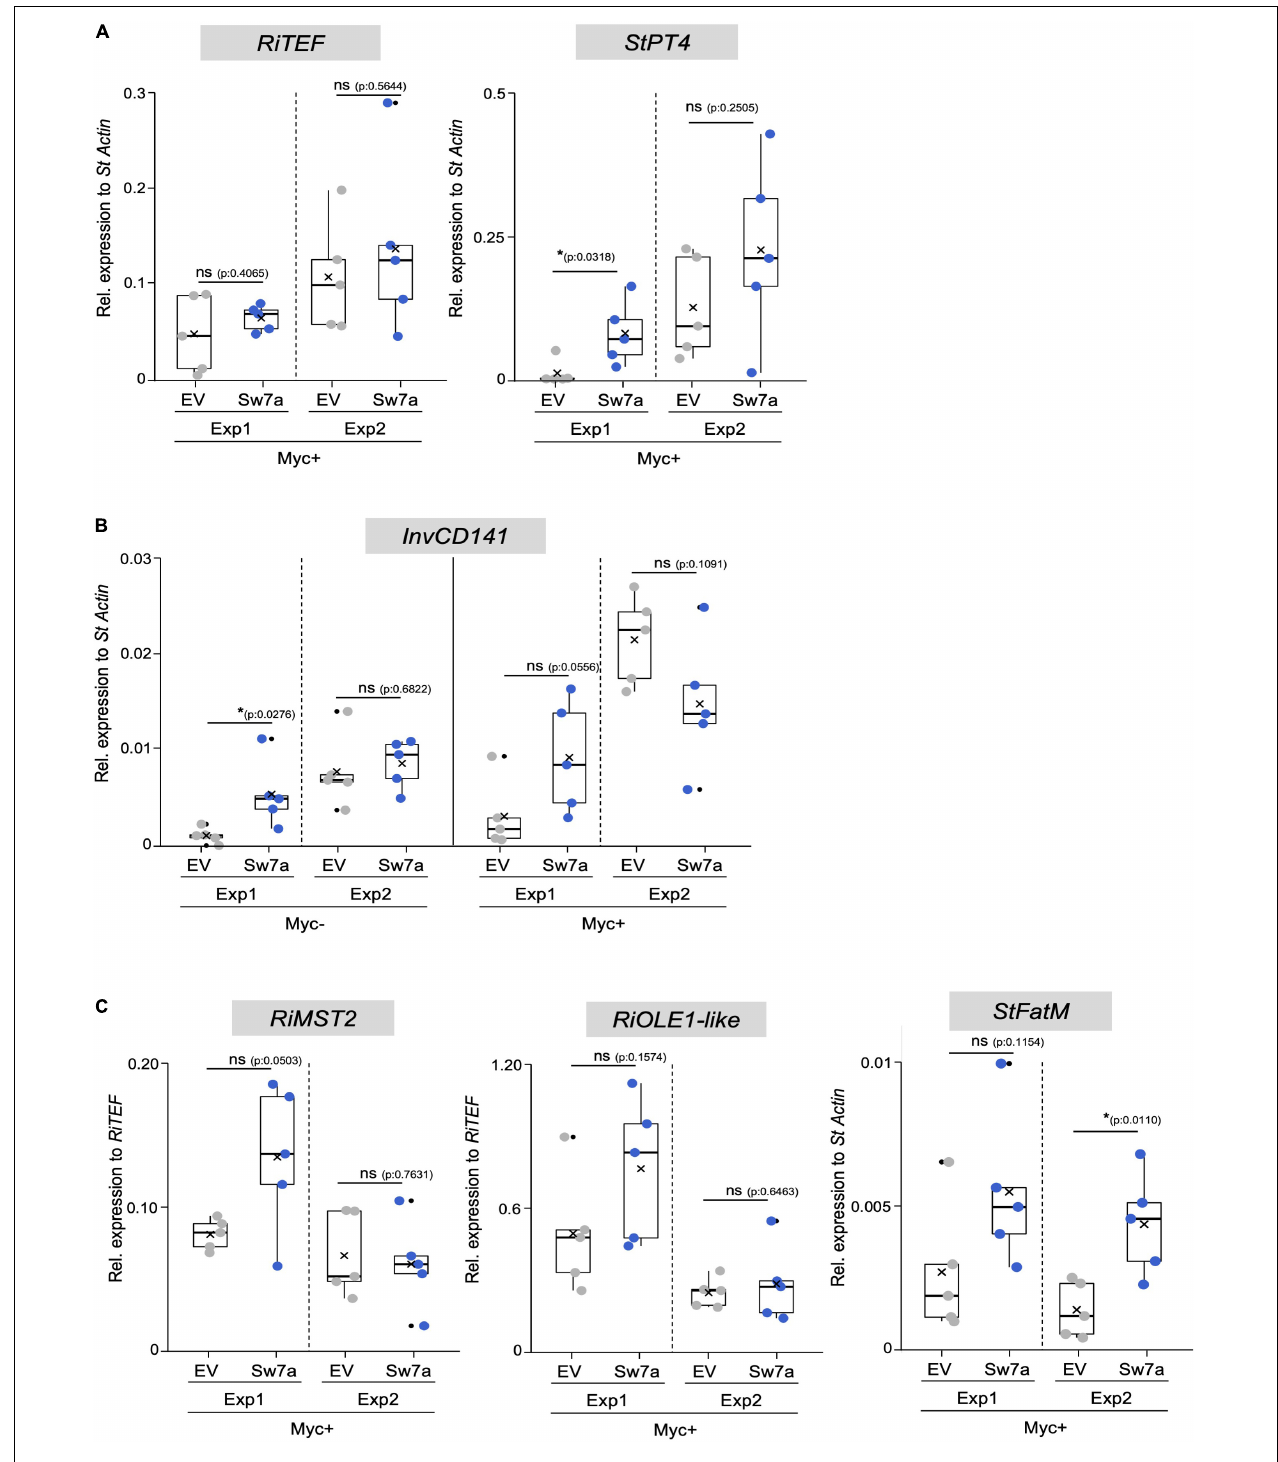
FIGURE 6 | Gene expression analysis in potato roots ectopically expressing StSWEET7a . The impact of StSWEET7a overexpression on the colonization by R. irregularis was analyzed by qRT-PCR in roots of composite plants under the two experimental conditions (Exp1 and Exp2) using several symbiotic markers. (A) RiTEF and StPT4 expression, (B) StlnvCD141 , (C) RiMST2 , RiOLE1 -like, StFatM . Transcript levels were normalized to StActin in the case of plant genes and RiTEF and to RiTEF in the case of fungal genes. Statistical significance was calculated either using a two-tailed Student’s T -test or the Mann–Whitney U test, depending on the normality, as explained in section “Materials and Methods.” Significance is given by p . Exact p -values are shown, ns, non-significant, p > 0.05; * p < 0.05; ** p < 0.01.